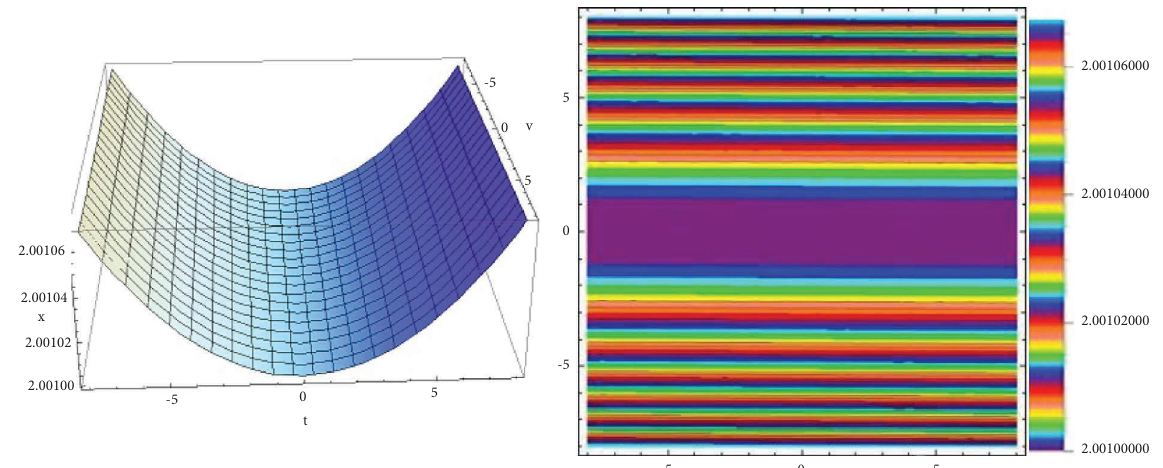
Figure 15: Concave parabolic wave soliton of (44) for ω � 0 . 004.